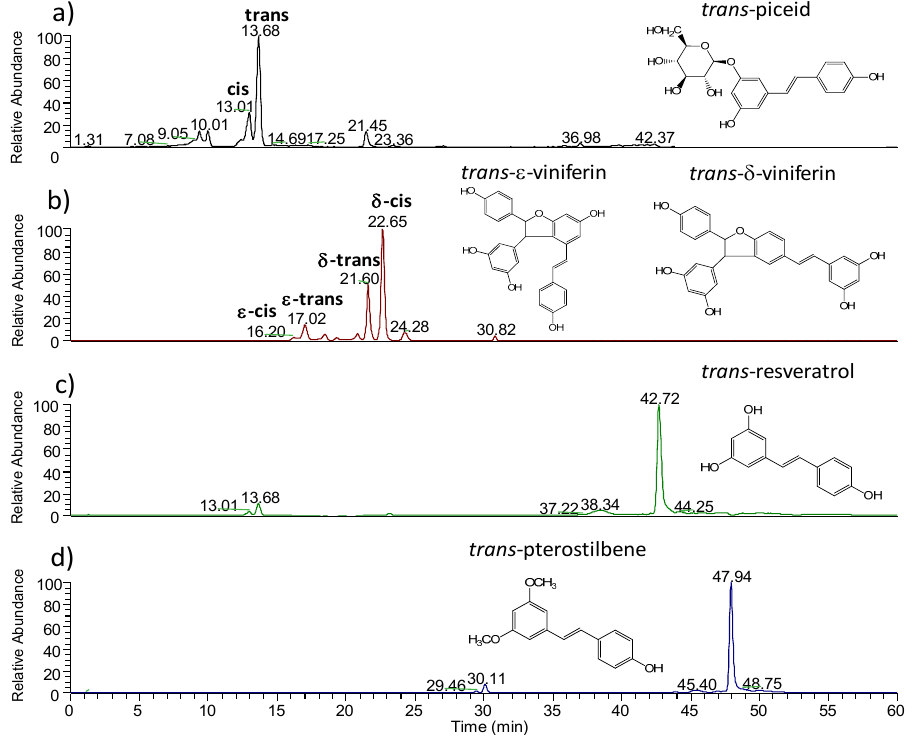
Figure 1. Ion extract chromatograms from HPLC-ESI/MS analysis of stressed leaf extract ( a ) piceid isomers at m/z 389 ( b ) viniferin isomers at m/z 453 ( c ) resveratrol at m/z 227 and ( d ) m/z pterostilbene at 255 – peak assignments were confirmed by MS/MS experiments of the 10 more abundant ions in each mass spectrum, the molecular structures of trans - isomers of each stilbene are